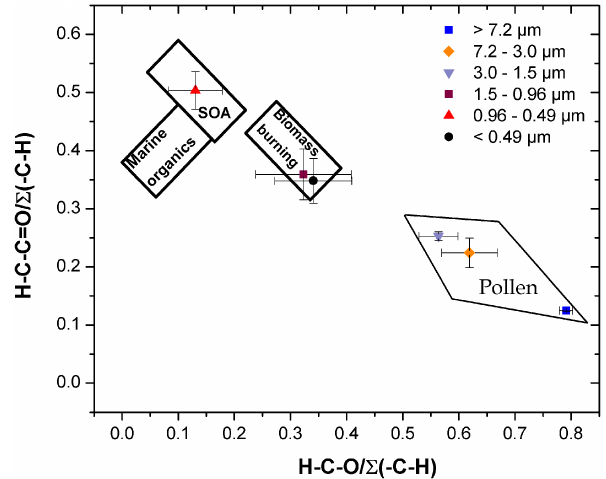
Figure 5. Association of the 13C isotopic ratio with the WSOC/particle mass ratio.